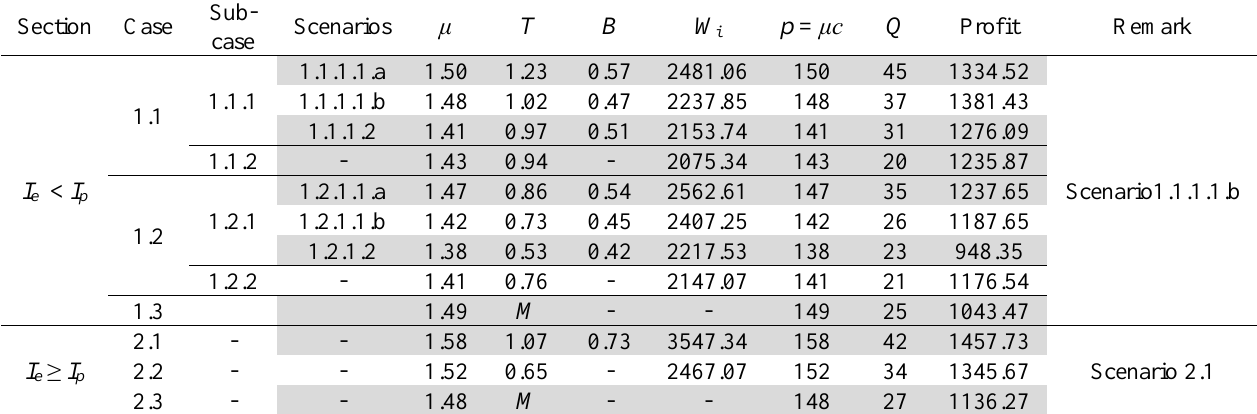
Result of Example 1 and 2 for different cases, sub cases and